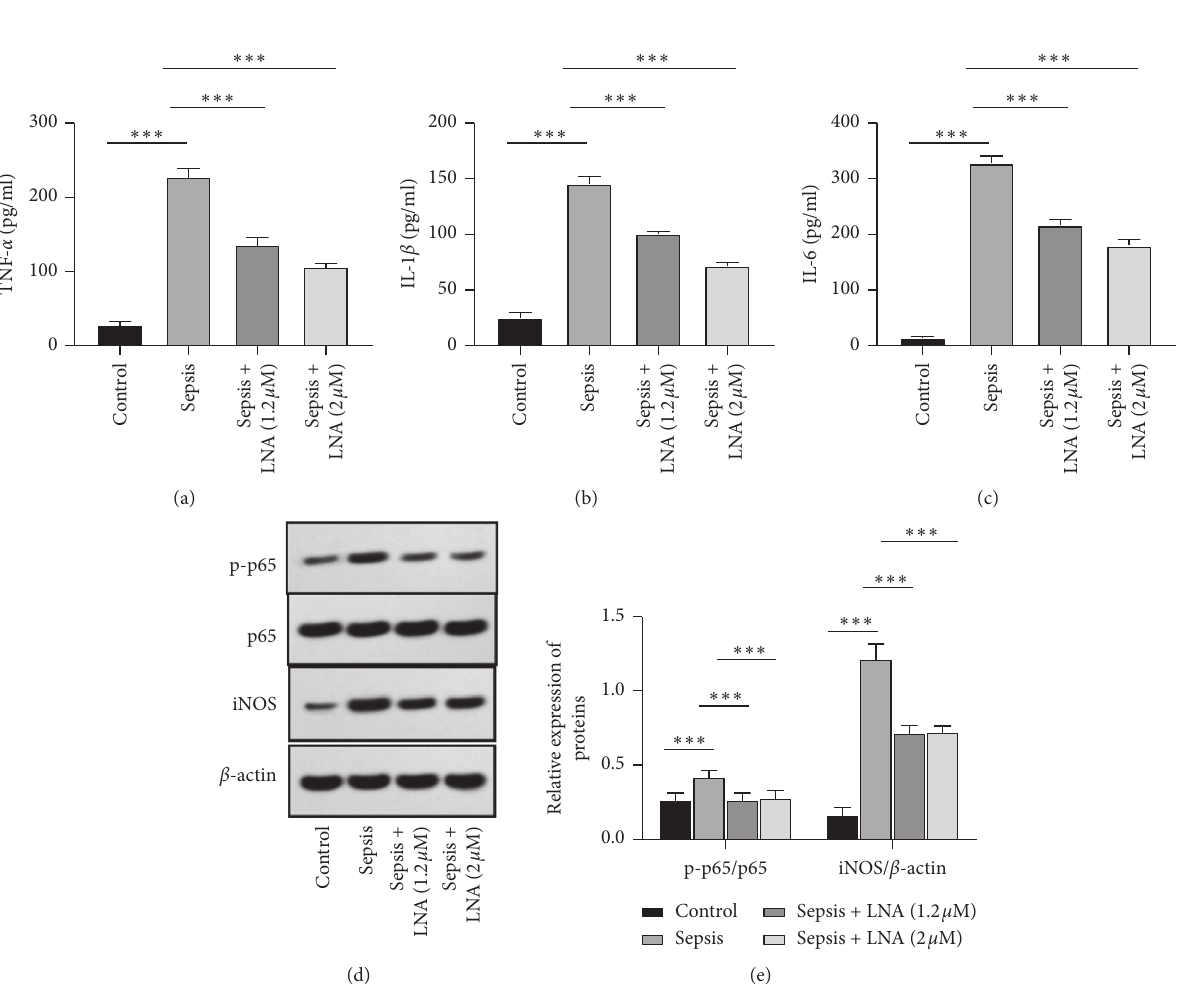
Figure 6: Lentinan reduces the inflammatory response of endothelial cells in sepsis. (a–c) Levels of TNF- α , IL-1 β , and Il-6 secreted by HUVECs cells in the control group (lentinan 0 μ M), sepsis group (sepsis group), sepsis+lentinan 1.2 μ M group (sepsis +LNA 1.2 μ M group), and sepsis+lentinan 2 μ M group (sepsis +LNA 2 μ M group); (d) detection of the p65 protein phosphorylation level and iNOS protein expression level by Western blotting. Values are expressed as mean ± standard deviation ( n � 4). Compared with the control group or the sepsis model group, ∗∗∗ P < 0 .